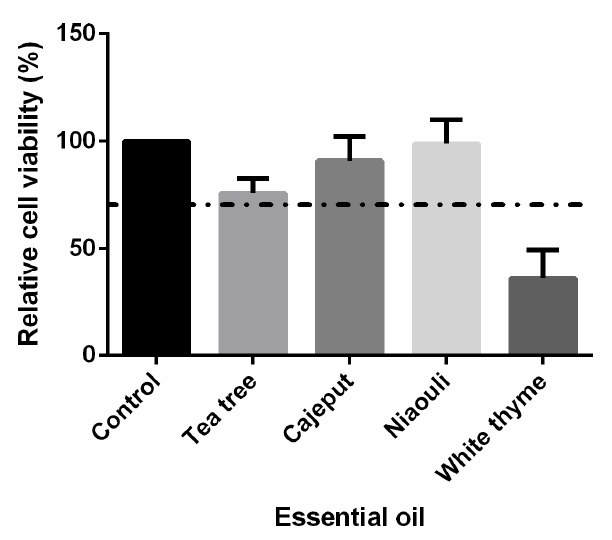
Figure 1. Vapor phase of essential oils’ (VP-EOs) cytotoxicity, expressed as the percentage of viable cells in relation to the absorbance values (OD 490 nm) of cells cultured without VP-EOs (100% cell viability). The dashed line represents the normative limit of 70% metabolic activity.